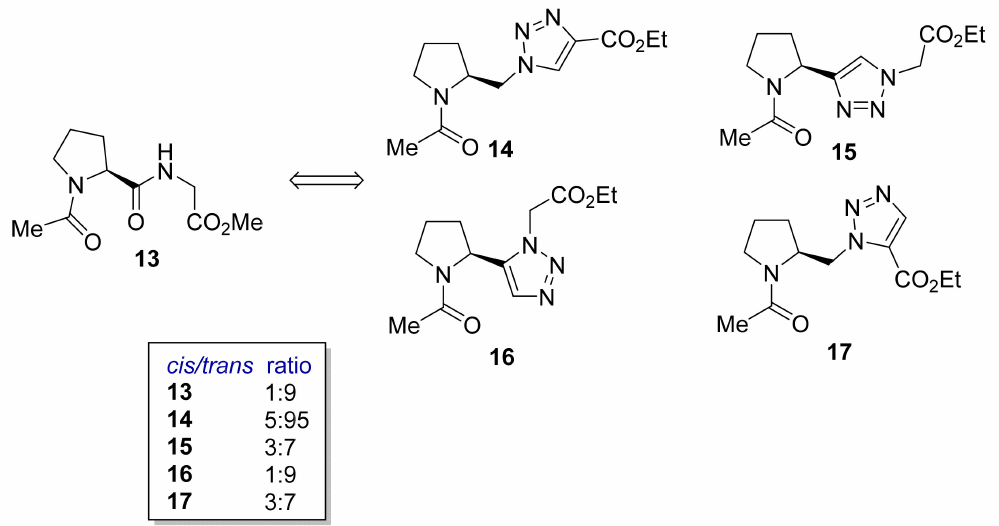
Figure 6. Peptidomimetics of the cis -amide